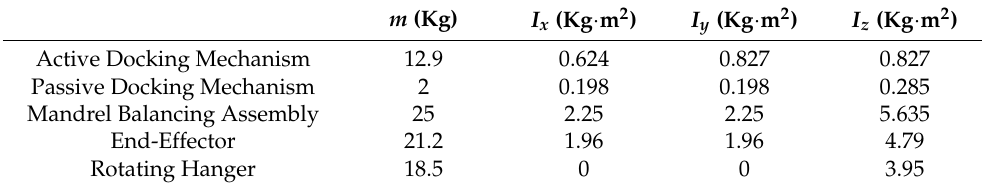
Table 2. Characteristic parameters of mass and